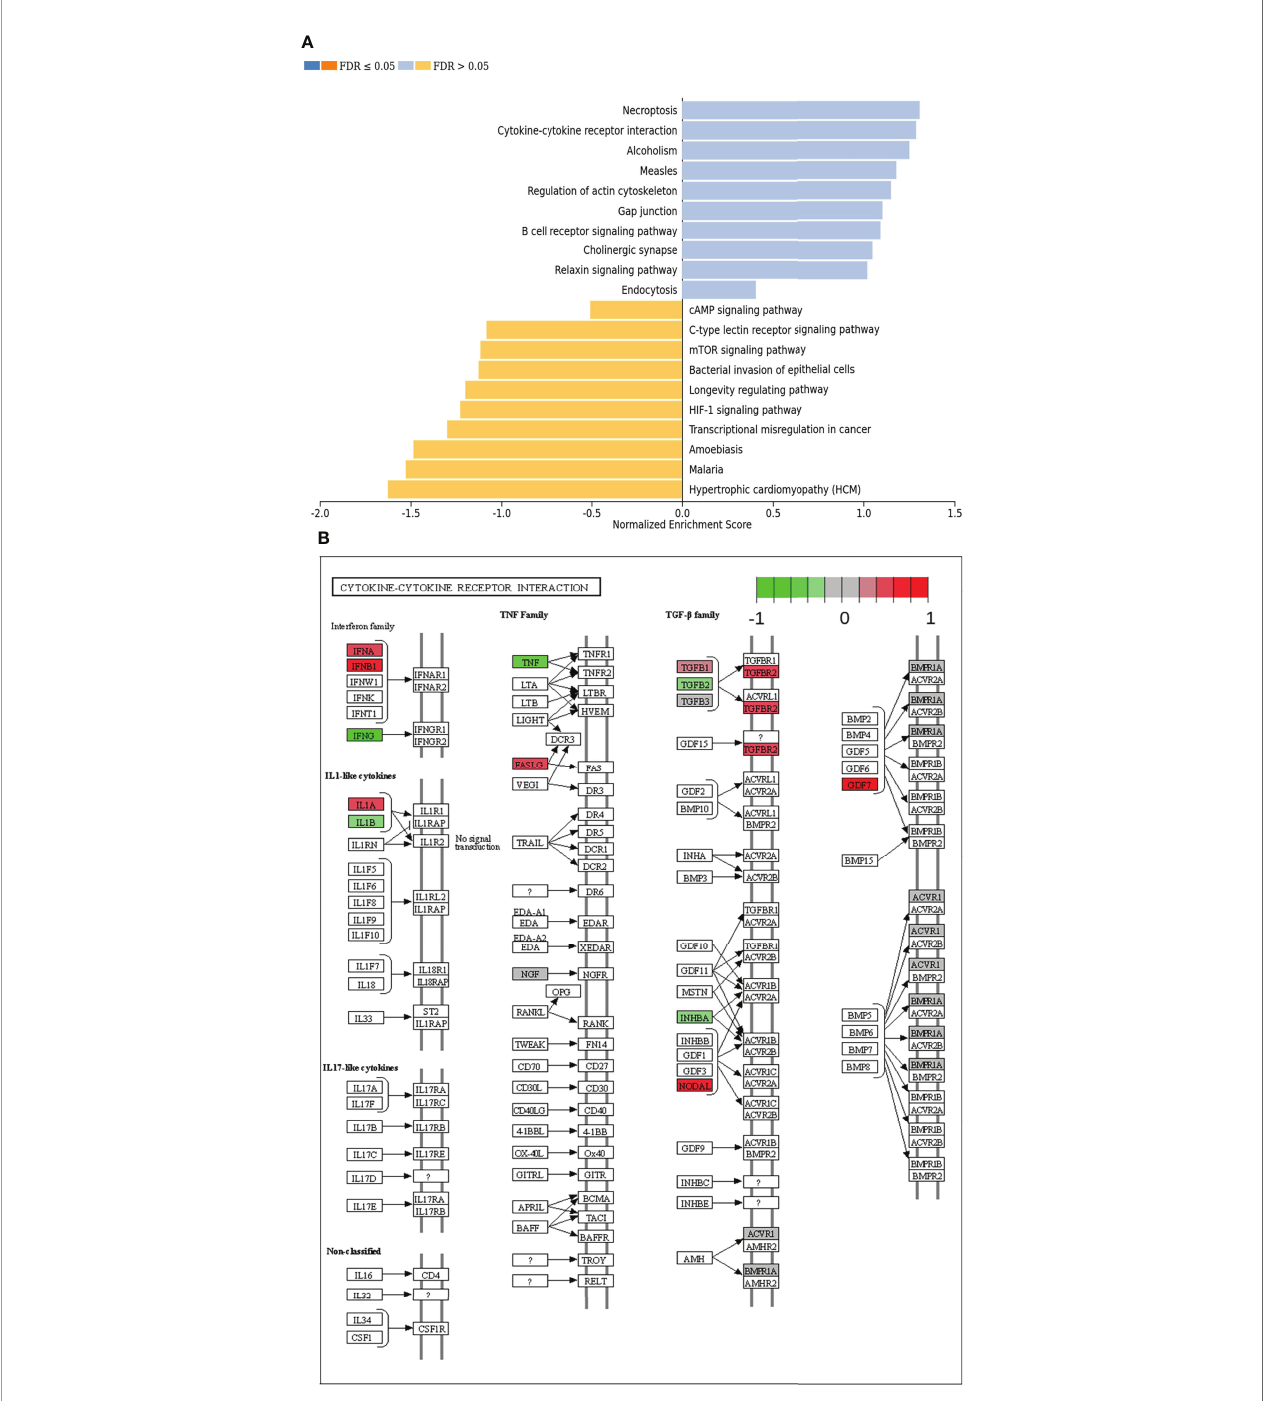
FIGURE 4 | (A) Gene set enrichment analysis of differentially expressed genes regarding therapy outcome in various signaling pathways. Blue: Genes in association with therapy outcome are strongly expressed in those pathways. Yellow: Genes in association with therapy outcome are barely expressed in those pathways. FDR: False Discovery rate. Due to testing the expression of certain genes in speci fi c pathways multiple times, the p-values are adjusted for the naturally occurring variance by the FDR method. (B) Genes expressed in association with “ Cytokine-cytokine receptor interaction ” and therapy failure in HGSOC. The color code indicates at differential gene expression whether the patients did not (red) or did respond well to chemotherapy (green). This molecular network map stems from the Kyoto Encyclopedia of Genes and Genomes (KEGG)